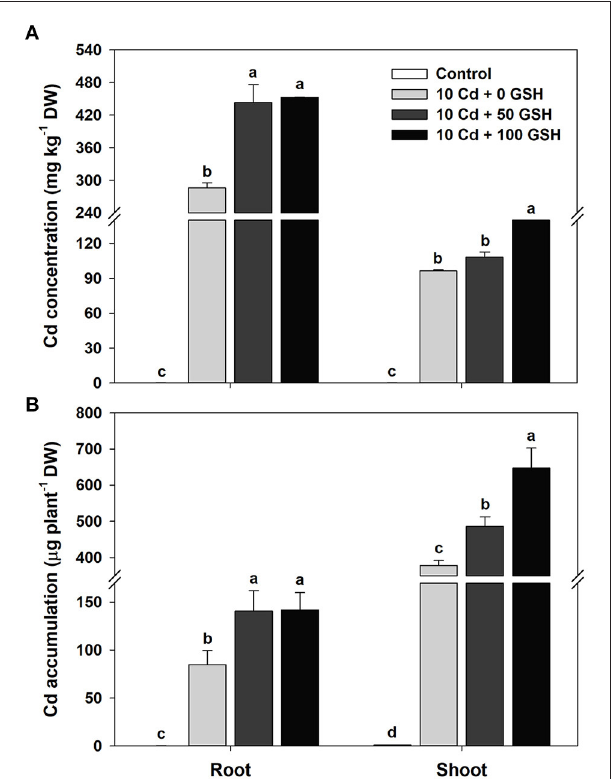
FIGURE 1 | Cadmium (Cd) (A) concentration and (B) accumulation in the roots and shoots of oilseed rape plants grown under control [no Cd or glutathione (GSH)] or 10 µ M Cd stress conditions sprayed with/without GSH (0, 50, and 100mg kg − 1 ). The concentration and accumulation of Cd were measured 10 days after treatment. Means denoted by the same letter are not significantly different at the P < 0.05 level according to Fisher’s least significant difference (LSD) test.